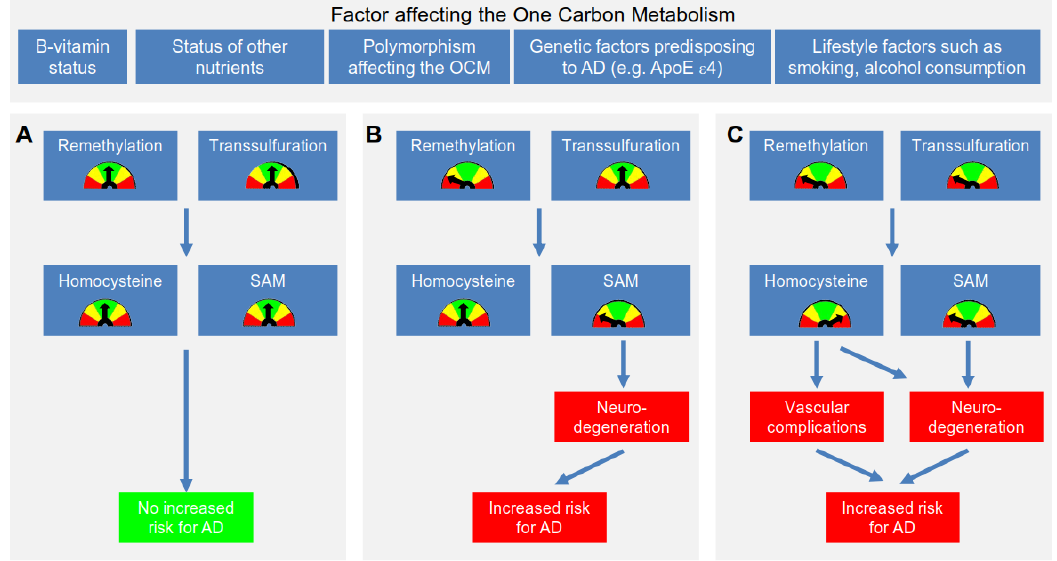
Figure 2. Proposed framework for the effect on genetic, nutritional and lifestyle factors on the development of Alzheimer’s disease: ( A ) Balance between remethylation and transsulfuration results in adequate levels of homocysteine, DNA synthesis, repair and methylation as well as synthesis of neurotransmitter, phospholipids and myelin and consequently no increase in the risk of Alzheimer’s disease; ( B ) Remethylation is decreased, while homocysteine is still kept in the normal range via transsulfuration, resulting in reduced DNA synthesis, repair and methylation as well as synthesis of neurotransmitter, phospholipids and myelin and consequently, an increase in the risk of Alzheimer’s, but not vascular disease; ( C ) Remethylation and transsulfuration are decreased, resulting in reduced DNA synthesis, repair and methylation as well as synthesis of neurotransmitter, phospholipids and myelin and consequently, an increase in the risk of Alzheimer’s, also due to compromised vascular health; AD: Alzheimer’s disease; ApoE: Apolipoprotein E; OCM: One-carbon metabolism; SAM: S -